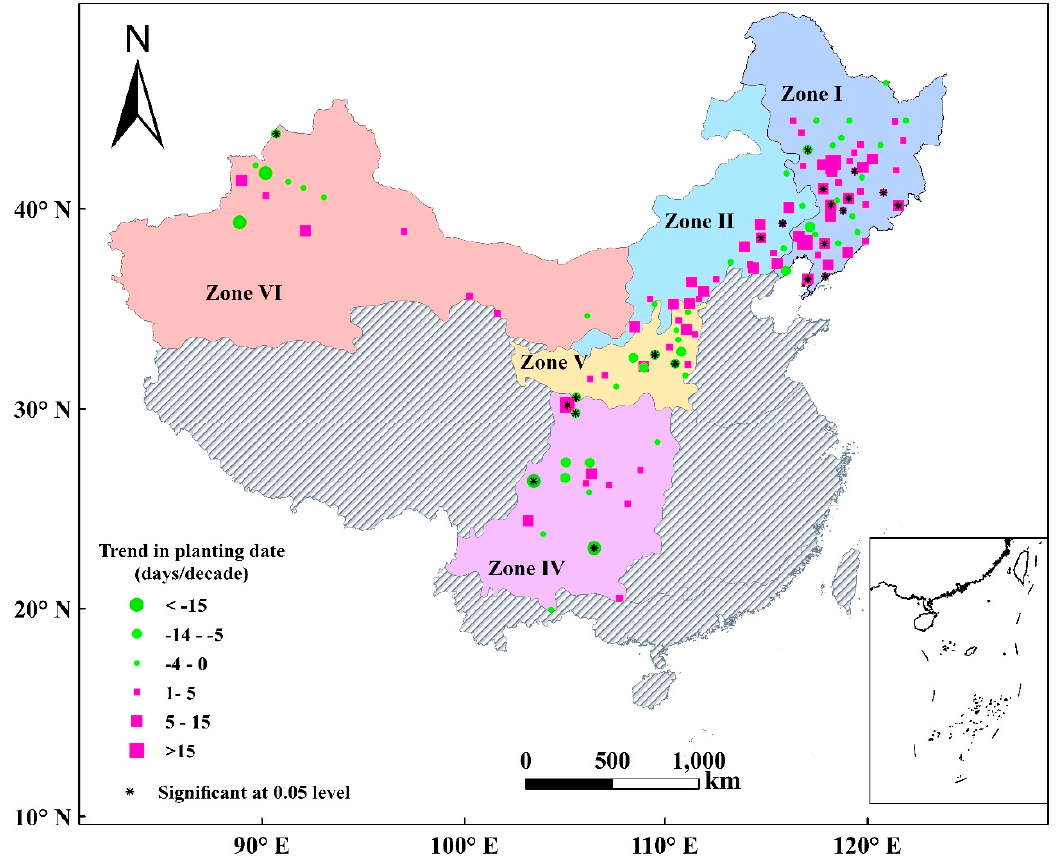
Figure 5. Trends in spring maize planting dates during the period of 1992 to 2010 at 124 agricultural meteorological experiment stations across China. The stations with trends significant at 0.05 level was marked by an